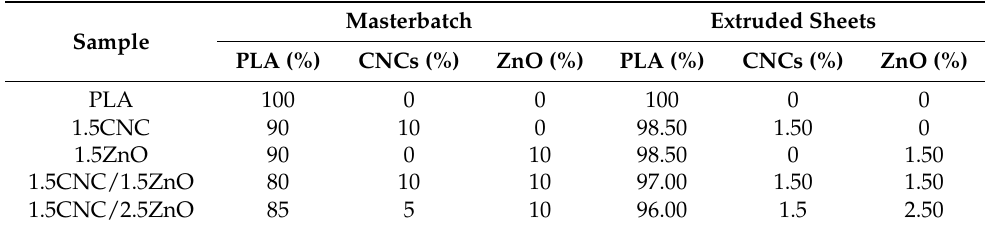
Table 1. Formulation of masterbatch and composite